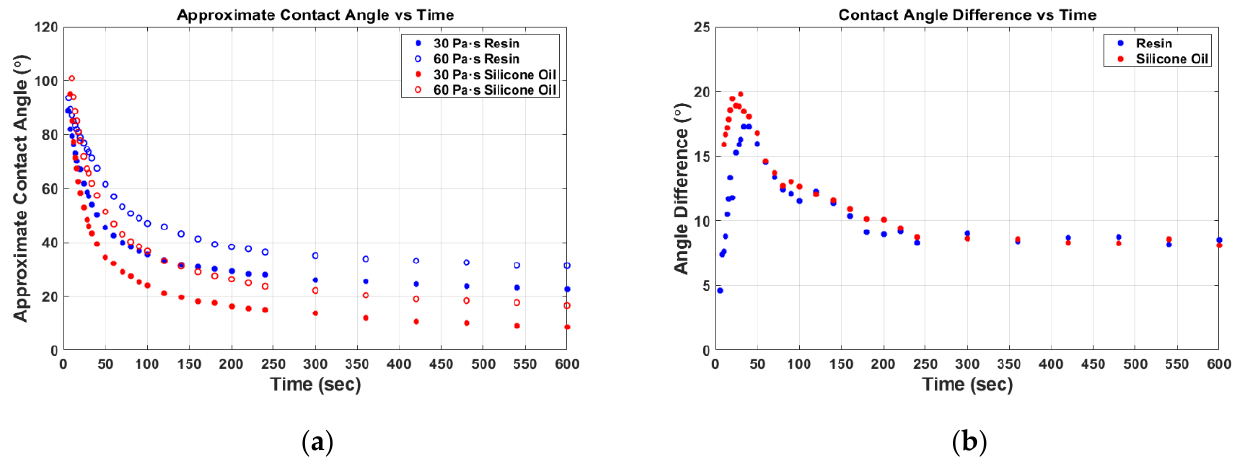
Figure 5. ( a ) Apparent contact angle of droplets of silicone oil and epoxy resin at 30 and 60 Pa·s viscosity. ( b ) Difference between the apparent contact angle of the 30 and 60 Pa·s droplets for both resin and facsimile fluid.